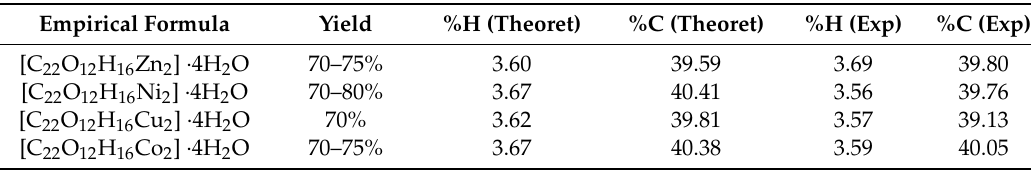
Table 1. Elemental analysis for metal complexes with cichoric